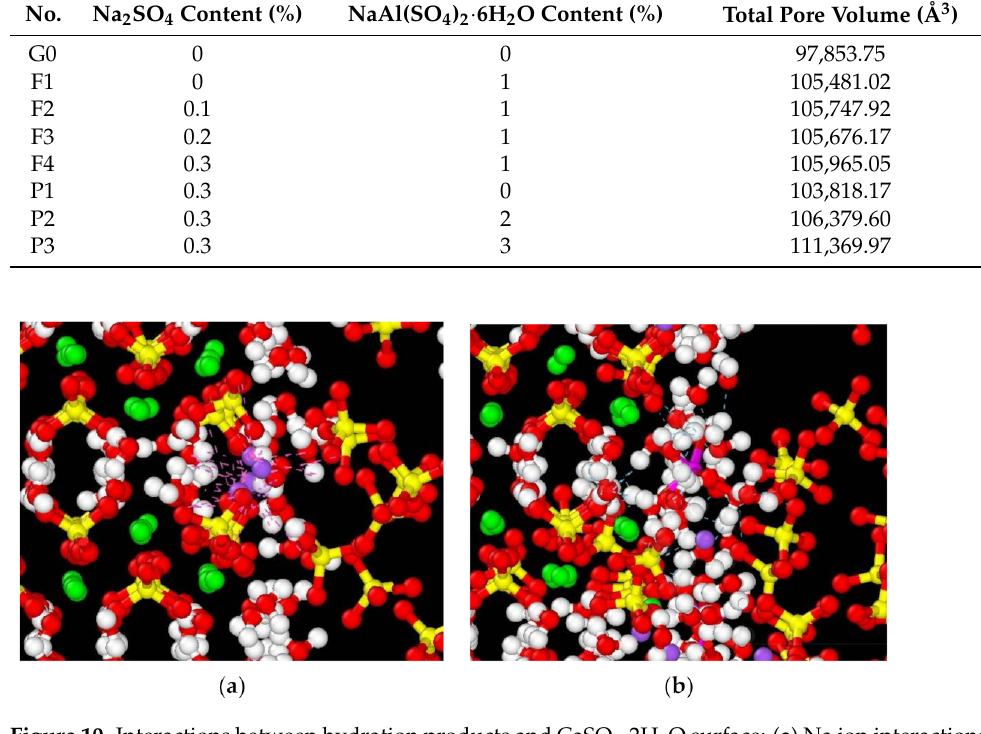
Figure 10. Interactions between hydration products and CaSO 4 · 2H 2 O surface: ( a ) Na ion interactions; ( b ) sodium aluminum sulfate interactions. (White balls are hydrogen, red balls are oxygen, yellow balls are sulfur, green balls are calcium, purple balls are sodium, and pink balls are